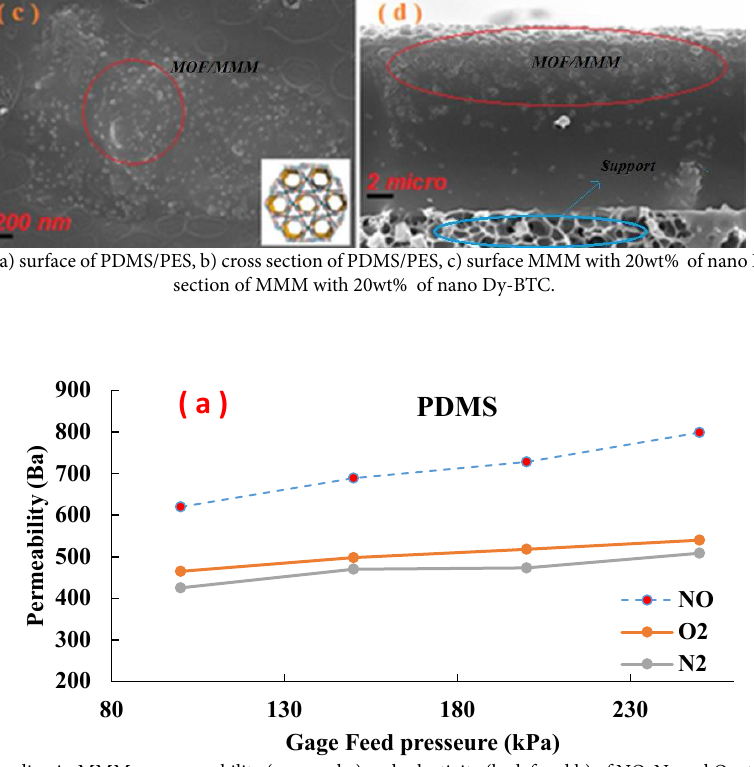
and O at 100-250 kPa feed 2 2